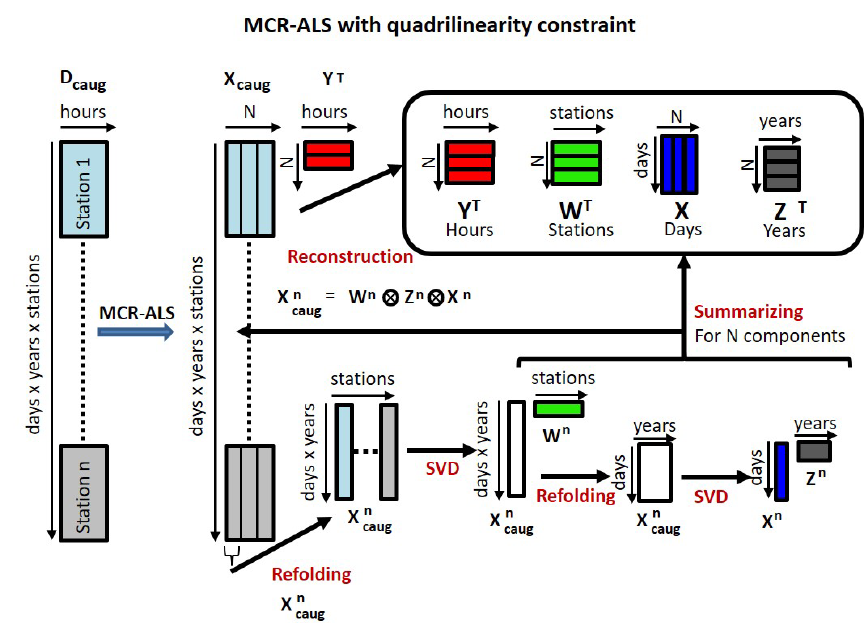
Figure 2. MCR-ALS with the quadrilinearity constraint. Graphical description of the implementation of the quadrilinearity constraint during the Alternating Least Squares (ALS) optimization. See Eqs. (4)–(7) and their explanation in the